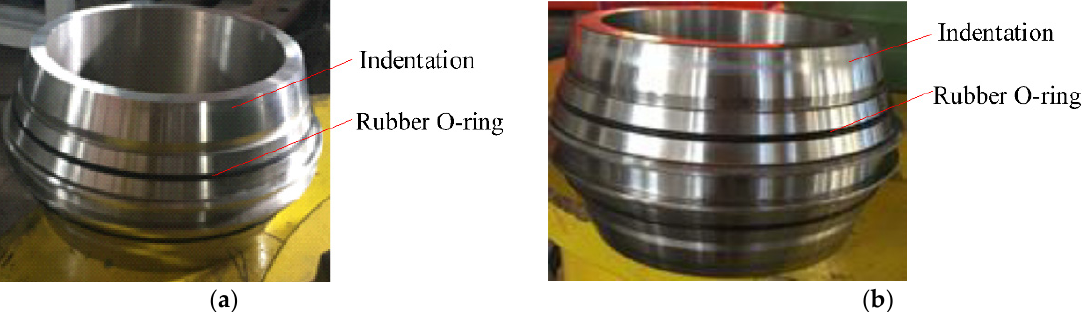
Figure 13. The state of the composite LSG after the test. ( a ) After the hydro-steady internal pressure test; ( b ) after the temperature cycle test.